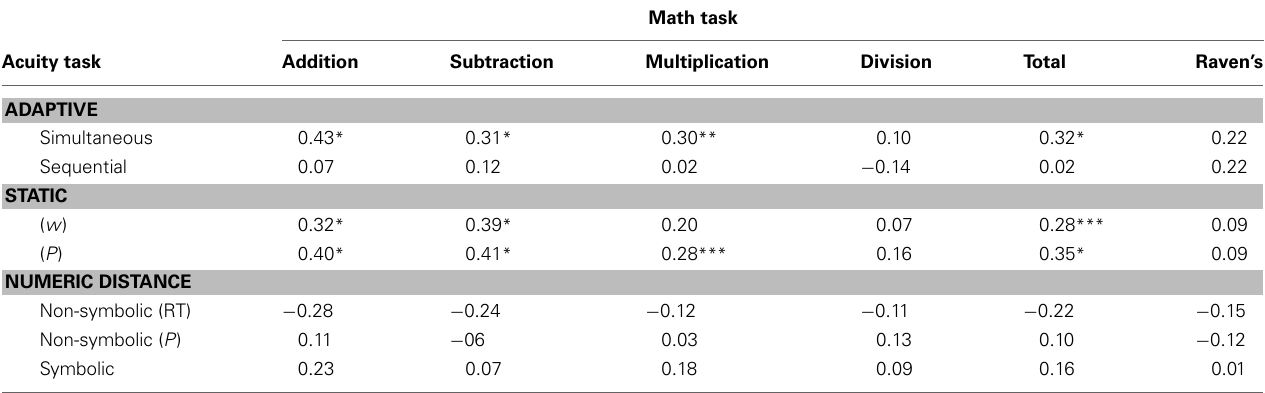
Table 3 | Correlations between all measures of ANS acuity and arithmetic fluency and intelligence (Raven’s